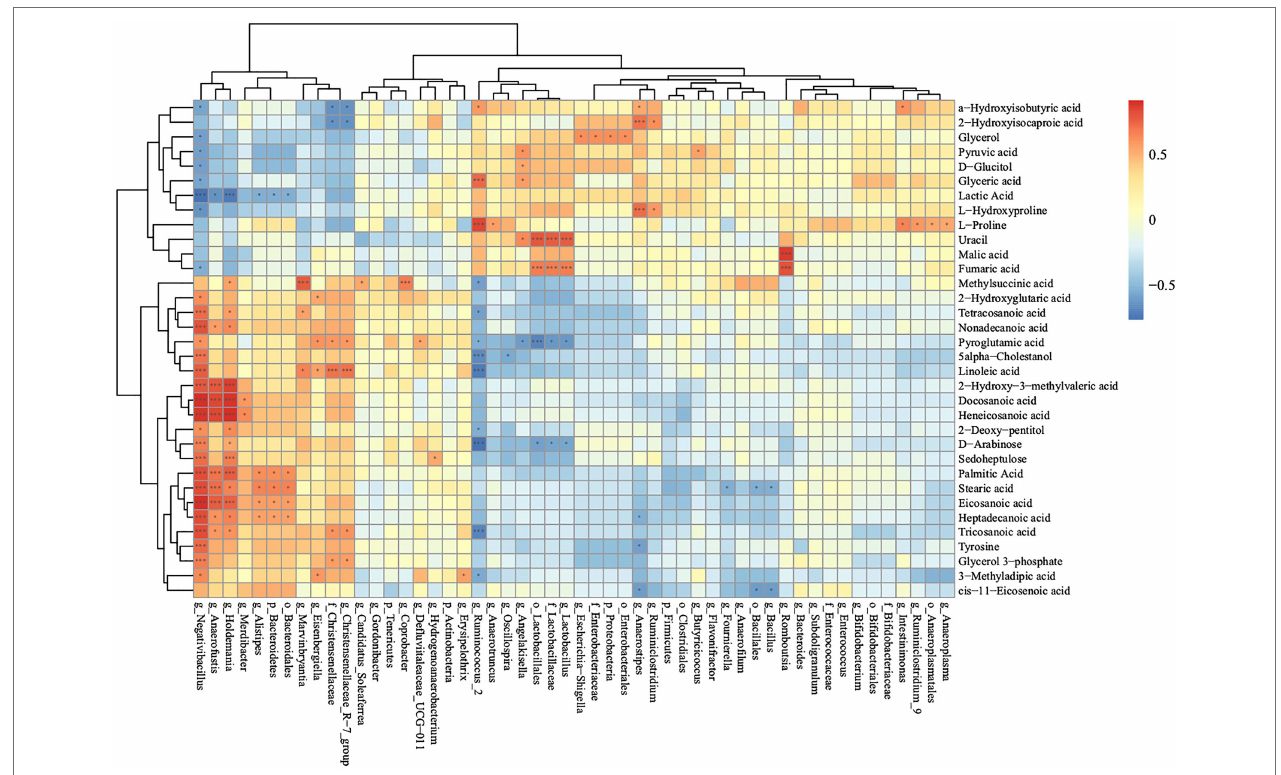
FIGURE 7 | Correlations of metabolome and microbiota in cecal contents according to the Spearman correlation coefficient distribution (SNE vs. BS). * p > 0.01 and p < 0.05; *** p < 0.01. Ctr group, basal diet in control group; SNE group, basal diet + SNE (20-fold dose coccidiosis vaccine) +1 ml of Clostridium perfringens (2 × 10 8 cfu/ml coinfection); BST group, basal diet (days 1–21) + 1 × 10 9 colony-forming units (cfu)/kg BS diet (days 22–63) +